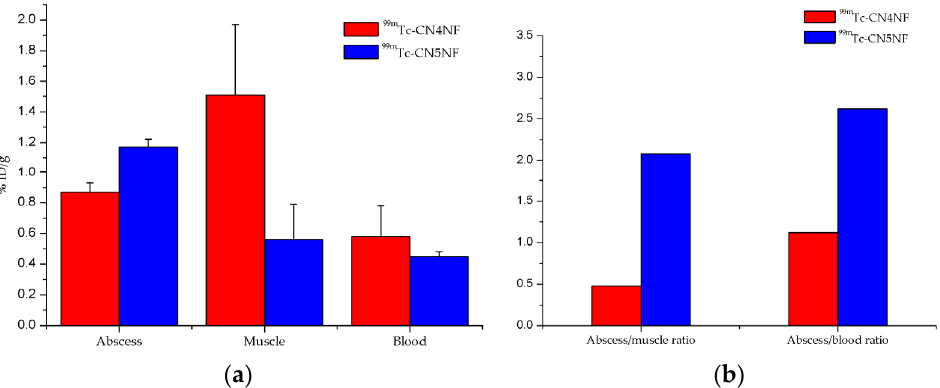
Figure 4. Comparison of the biodistribution in mice of [ 99m Tc]Tc-CN4NF and [ 99m Tc]Tc-CN5NF. ( a ) Infection uptake of the complexes at 4 h post-injection; ( b ) target/non-target ratio of the complexes at 4 h post-injection.